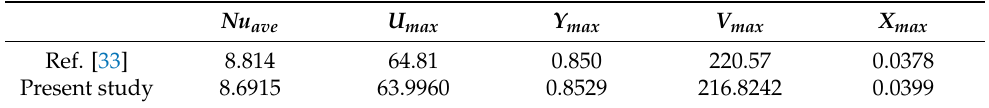
Table 9. Dimensionless results for Ra = 10 6 . Nu